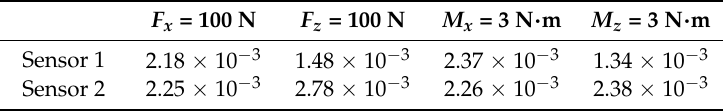
Table 5. Relationship between total strain and loading force or torque